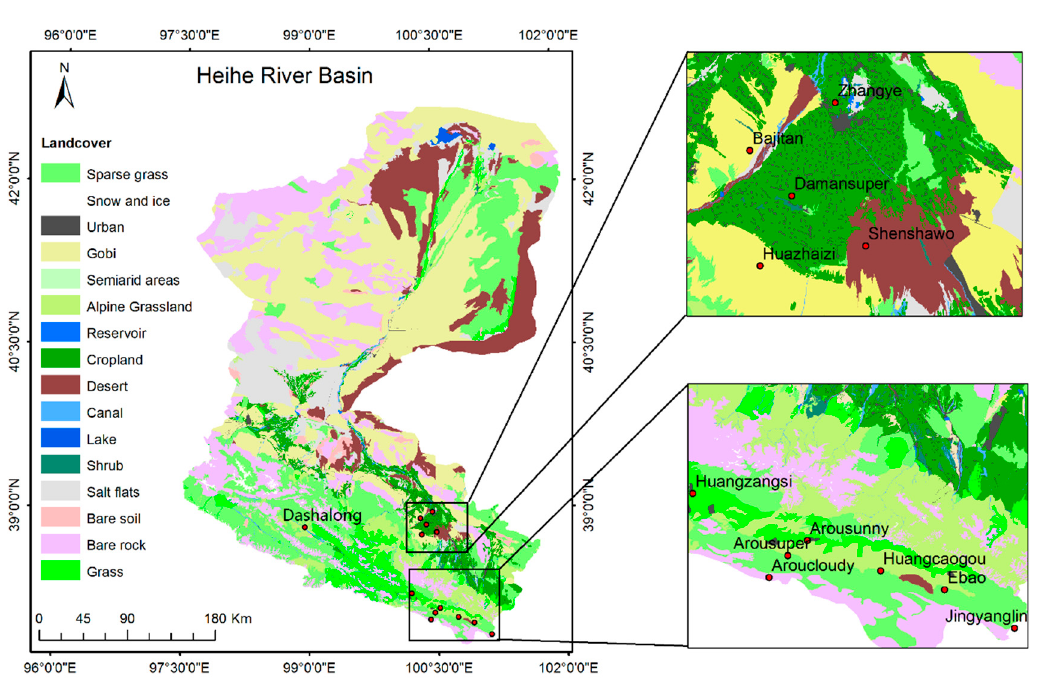
Figure 1. Land cover map of the Heihe River Basin, with zooms showing the spatial distribution of the measurement sites.